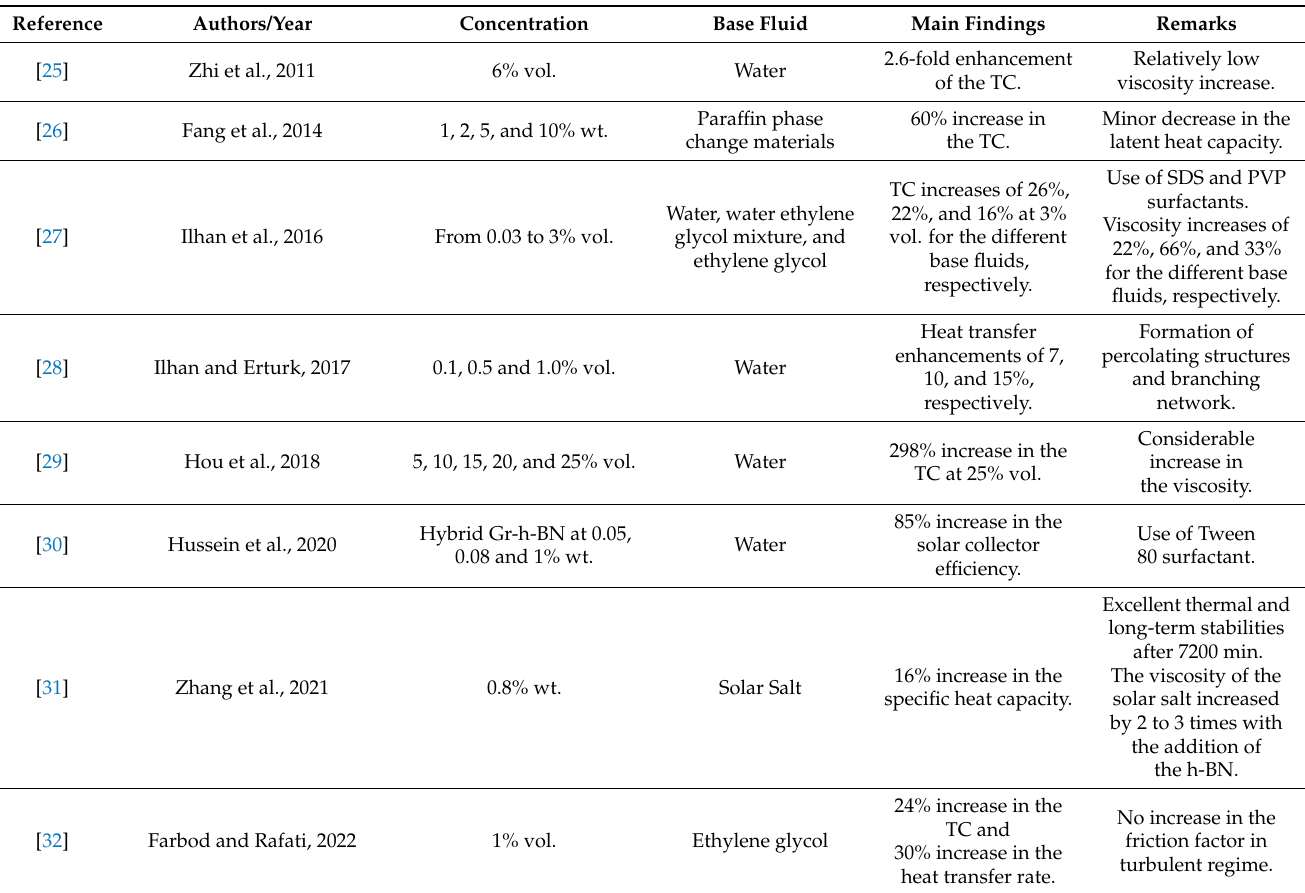
Table 1. Recent studies on h-BN and hybrid